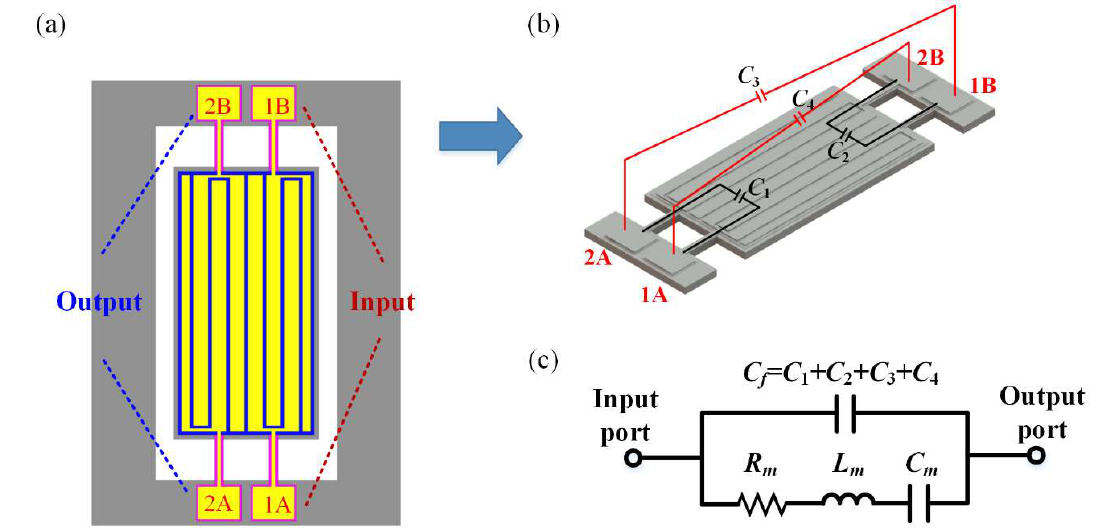
Figure 2. Schematic of the parasitic capacitive feedthrough in the proposed resonator. ( a ) Ports 1A and 1B are input ports, and ports 2A and 2B are output ports. The electrodes are divided into two sets: set A and set B. The electrodes in the same set are connected to input and output ports respectively (e.g., 1A and 2A). ( b ) C 1 and C 2 are the direct feedthrough between the input and output ports within one set. C 3 and C 4 are the cross feedthrough between the input and output ports belonging to different sets. ( c ) Traditional Butterworth-van Dyke (BVD) equivalent circuit model of the proposed resonator.